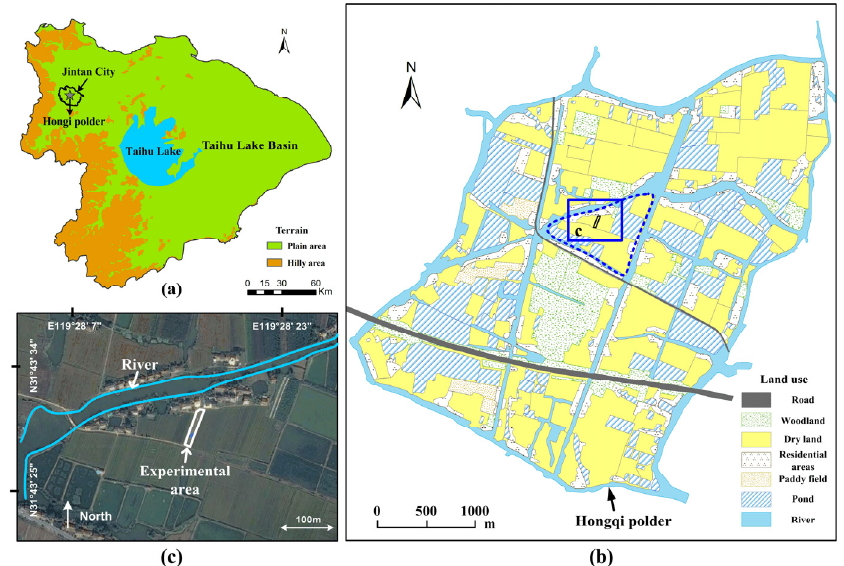
Figure 1. Information of the experimental field: ( a ) location of Hongqi polder; ( b ) land use of Hongqi polder; ( c ) location of the experimental field.